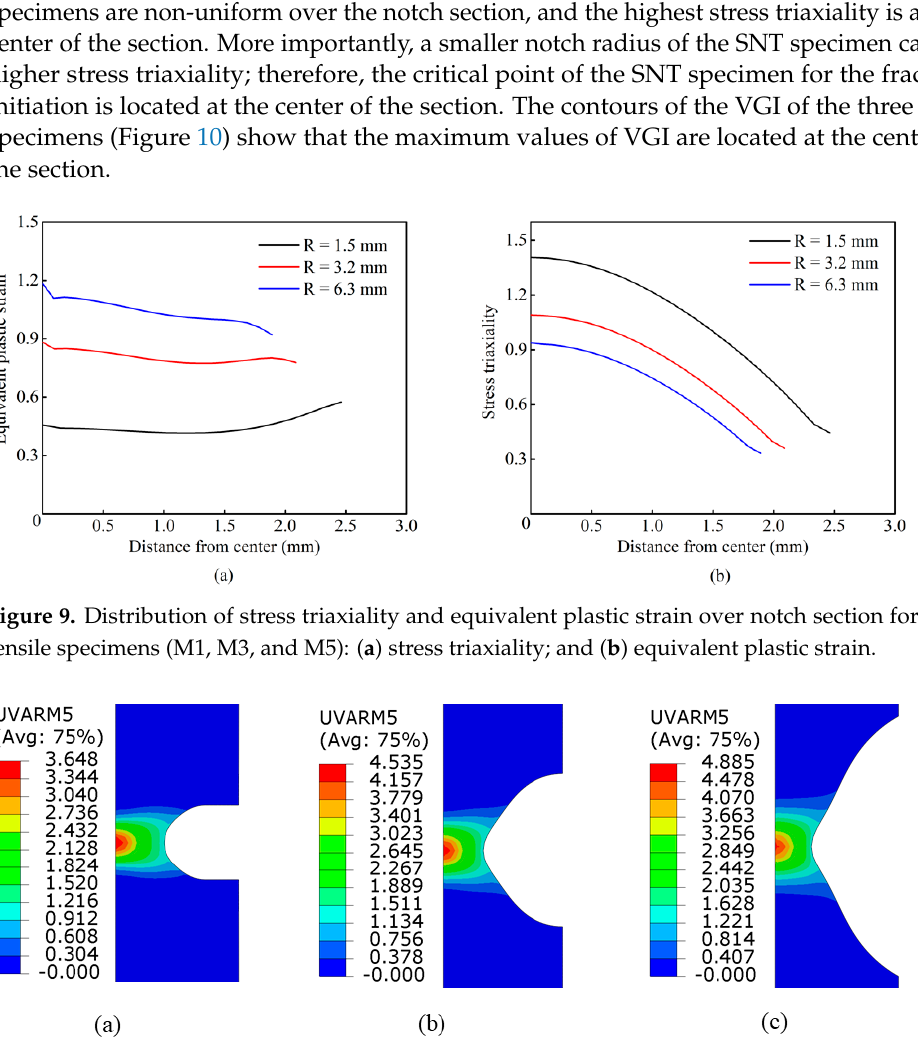
Figure 10. VGI distribution at fracture initiation: ( a ) Specimen M1 (R = 1.5 mm); ( b ) Specimen M3 (R = 3.2 mm); and ( c ) Specimen M5 (R = 6.3 mm).